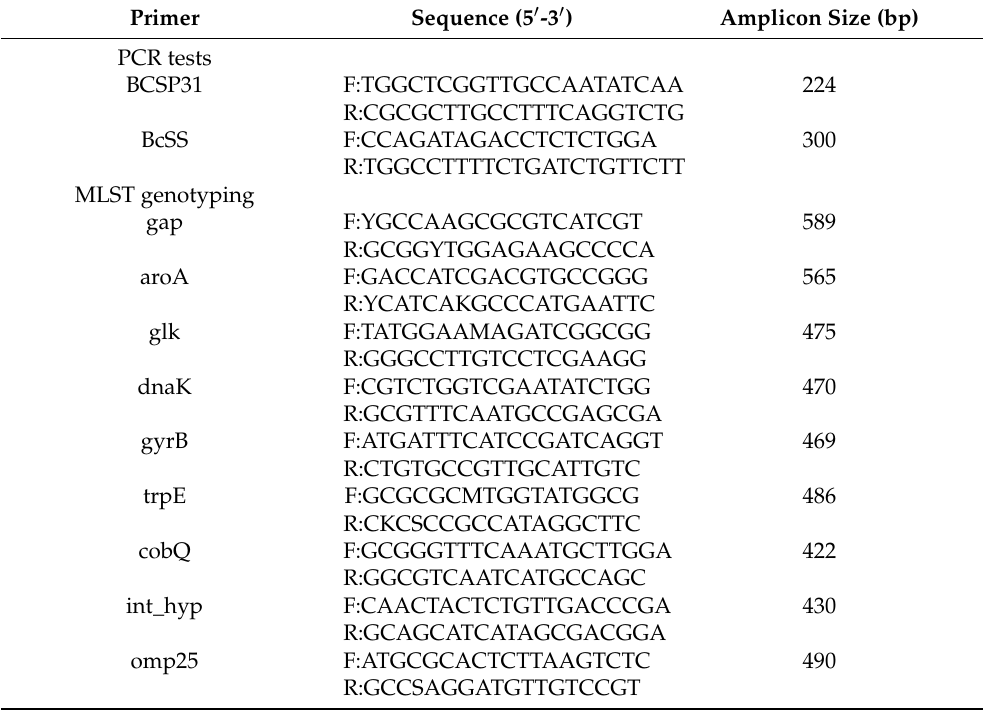
Table 1. Primers used in PCR tests and MLST